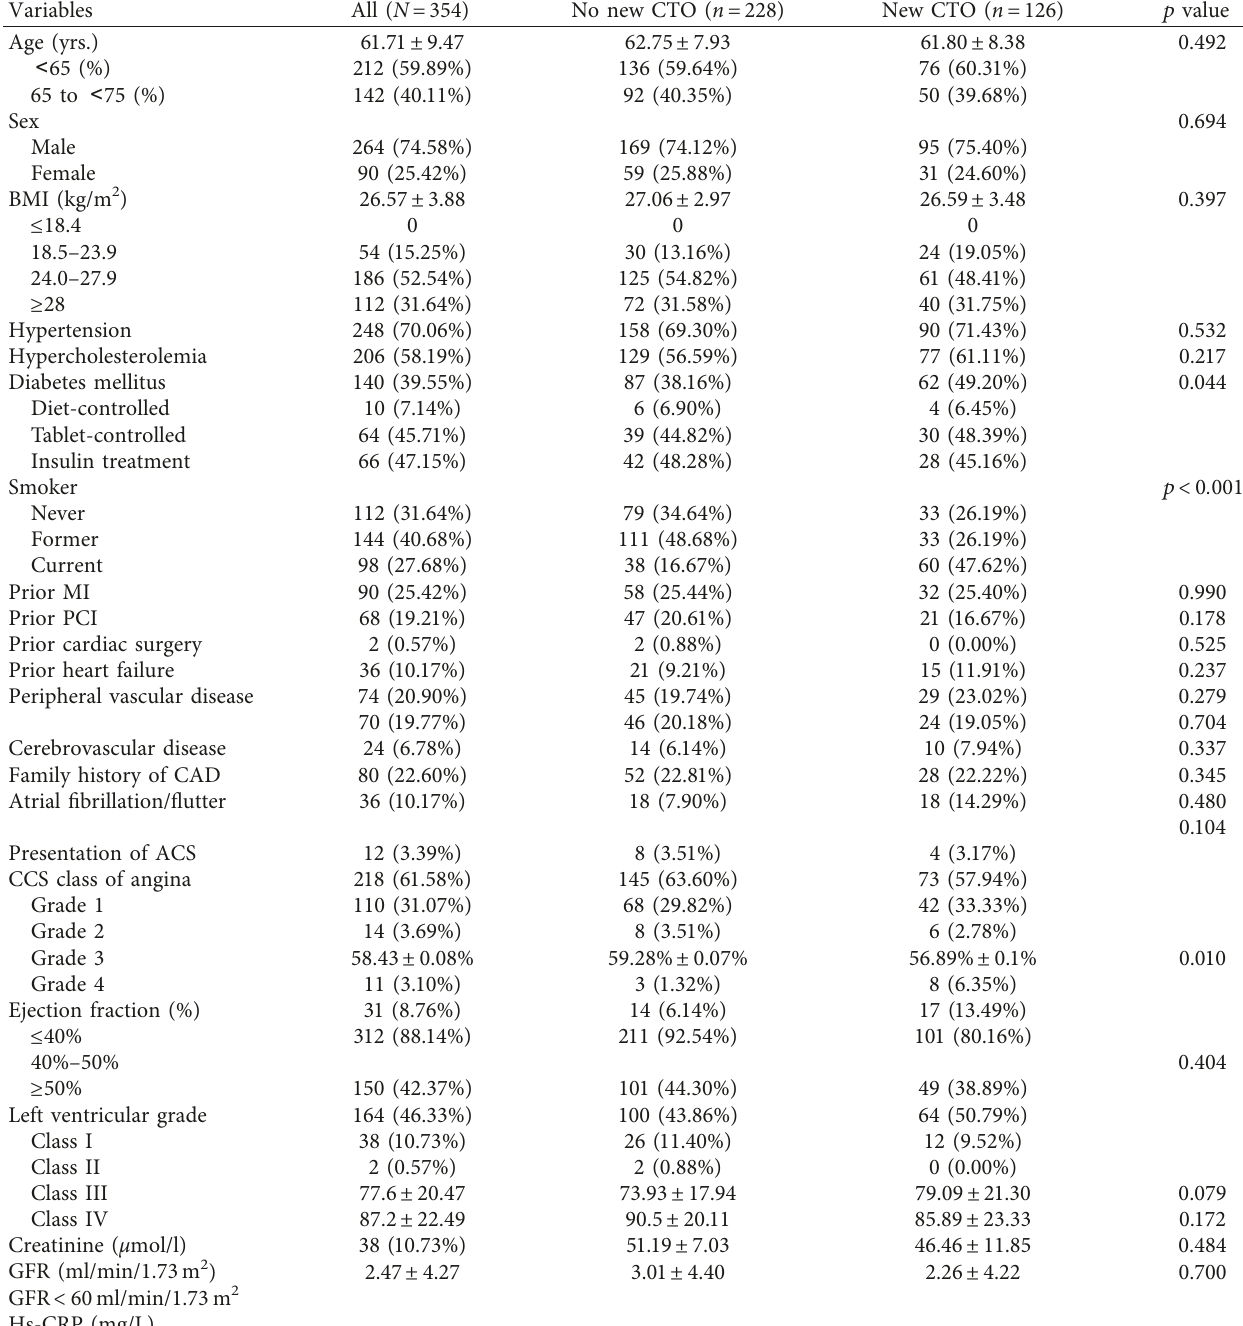
Table 1: Baseline patient